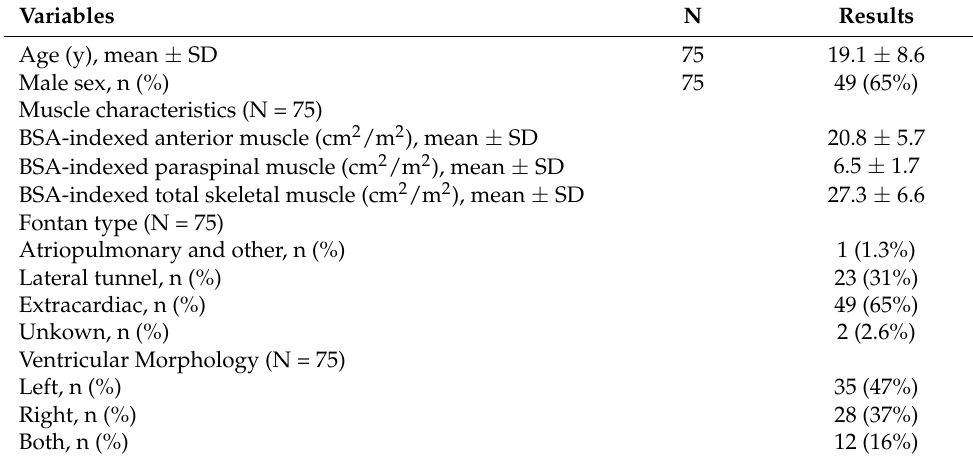
Table 1. General characteristics.